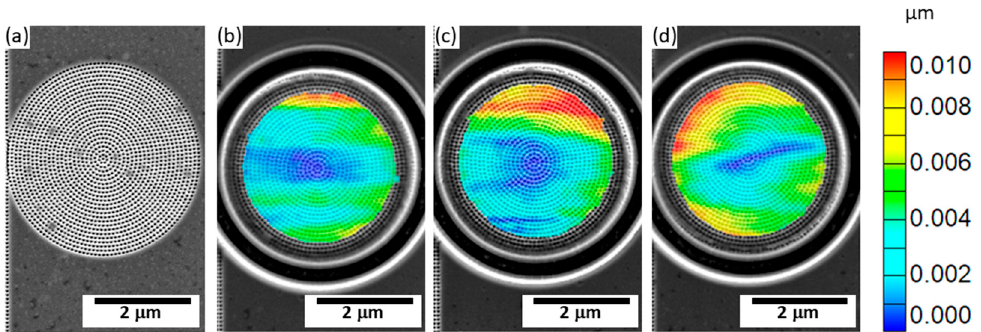
Figure 9. FIB-DIC measurements were performed on trivalent chromium deposits. ( a ) Initial speckle before annular groove ablation, ( b – d ) displacement amplitude fields obtained by DIC after completed ablation, and untreated trivalent chromium samples 1 to 3.